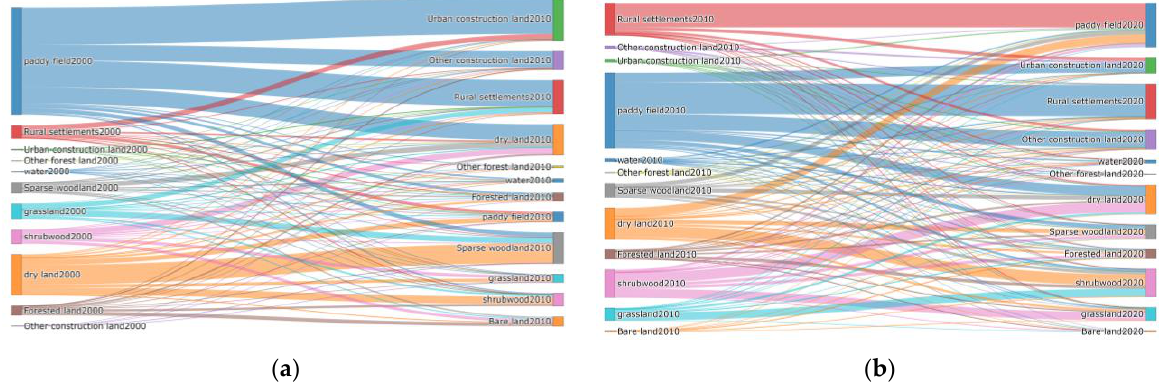
Figure 10. Sankey diagram of land-use transfer ( a ) from 2000 to 2010 and ( b ) from 2010 to 2020. Table 4. Net change of land-use structure in the “Western Protected Area” from 2000–2020 (km 2 ). Land-Use Type Low Coverage Grassland